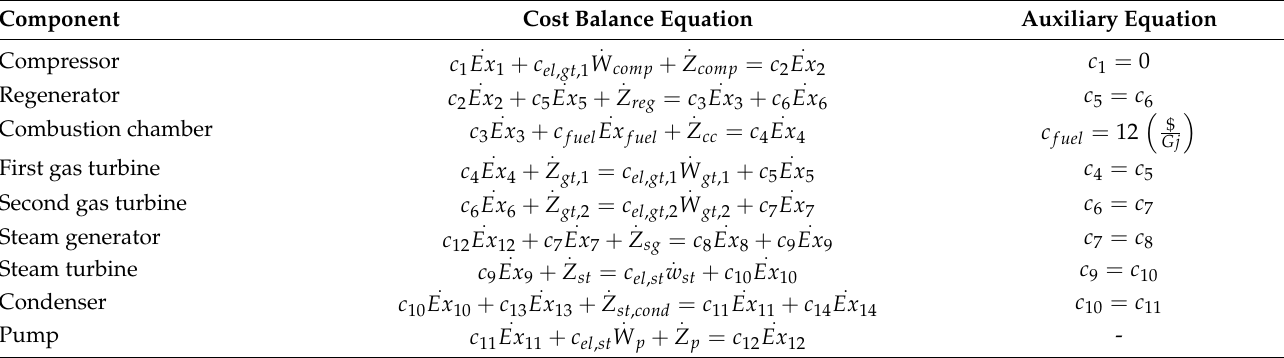
Table 4. Cost balance and auxiliary equations of combined cycle system shown in Figure 3. Component Cost Balance Equation Auxiliary